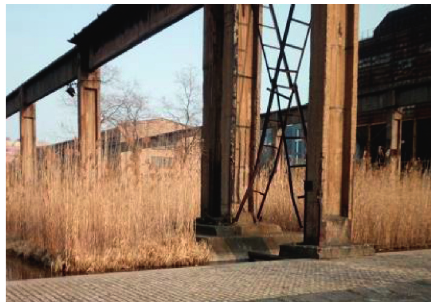
Figure 6: A corner of the factory.